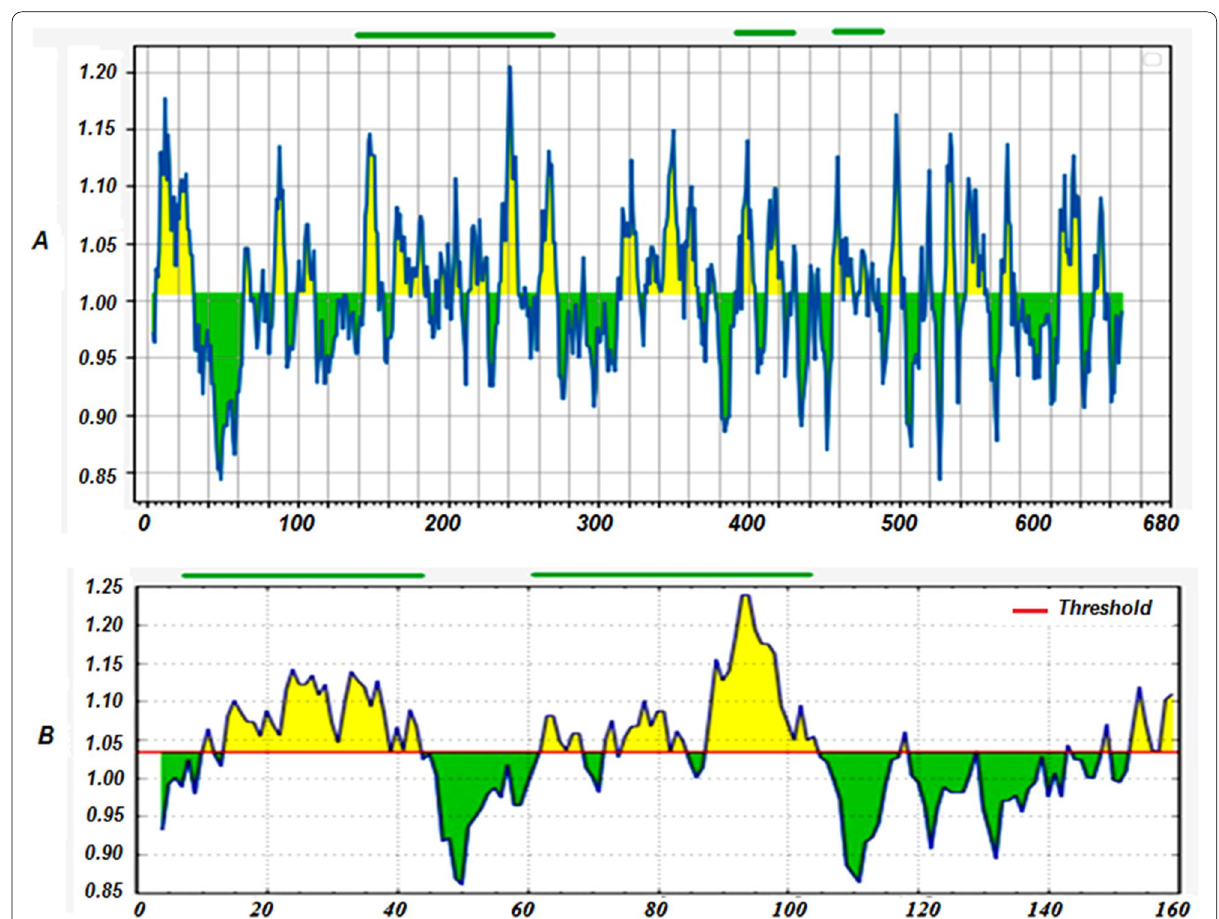
Fig. 1 Antibody epitopes predicted by Kolaskar and Tongaonkar antigenicity method. A Three antigenic regions 144 to 274, 394 to 420, and 454 to 480 were considered in the pMGA protein. B Two antigenic regions 13 to 45 and 62 to 104 were chosen in Pvpa